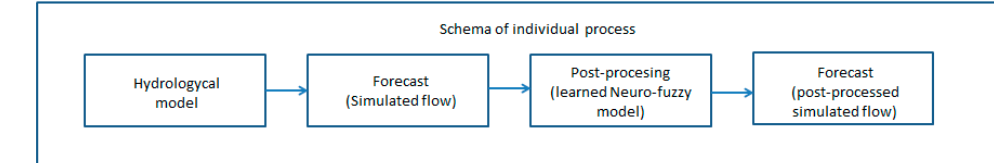
Table 1. Parameters used for model construction. Figure 1. Scheme of important process.